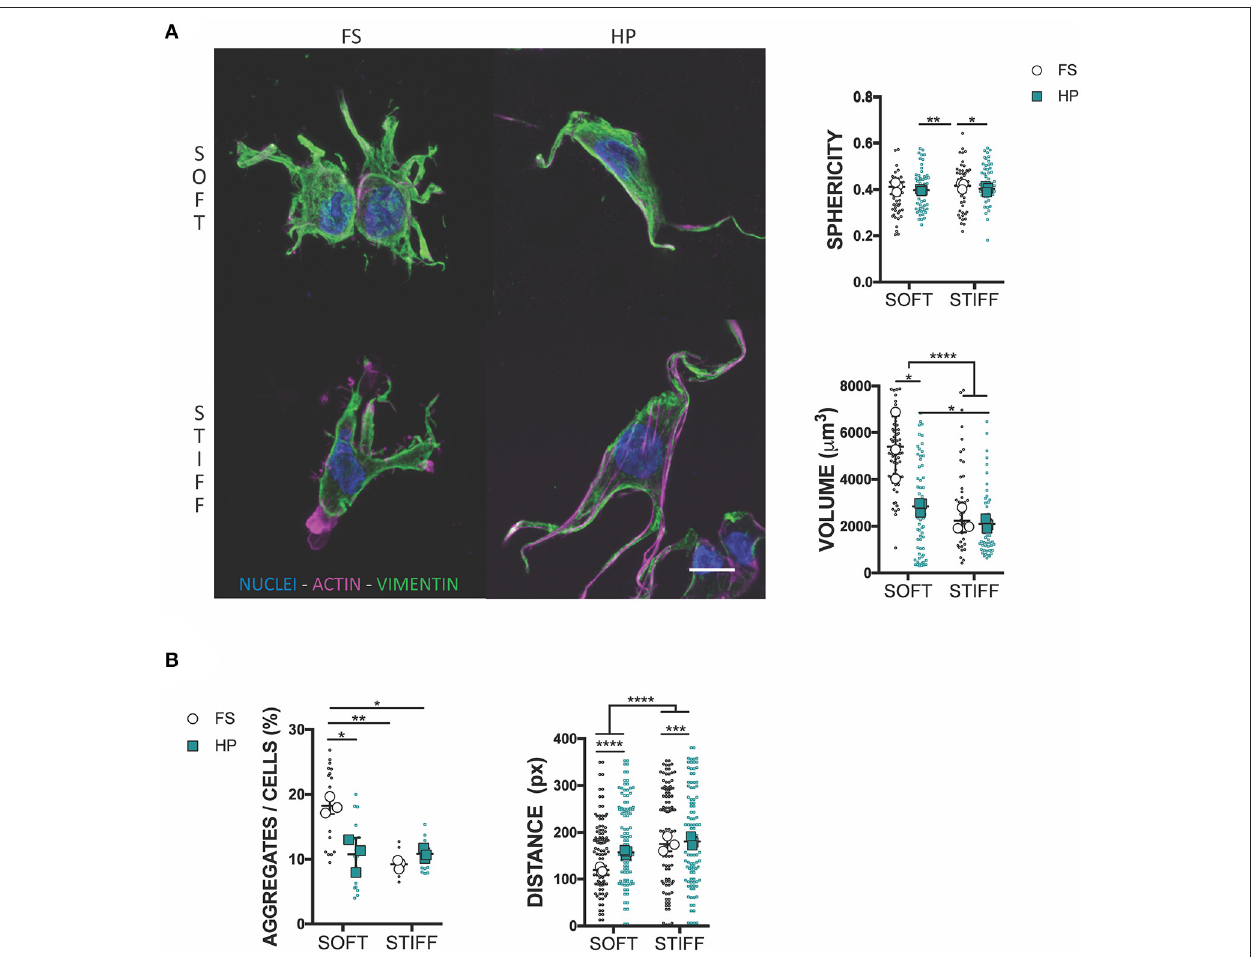
FIGURE 3 | HP stimulation inhibits MSCs aggregation. (A) Confocal analysis of MSCs cultured for 7 days in presence of TGF- β 3 and HP. Cells stained for nuclei (blue), actin (magenta) and vimentin (green). Scale bar, 10 µ m. Graphs reporting the values of sphericity and volume of single cells embedded into 3D IPN. (B) Average percentage of cell aggregates per field of view after 7 days of culture and cell-cell distance. * p < 0.05, ** p < 0.01, *** p < 0.001, **** p <